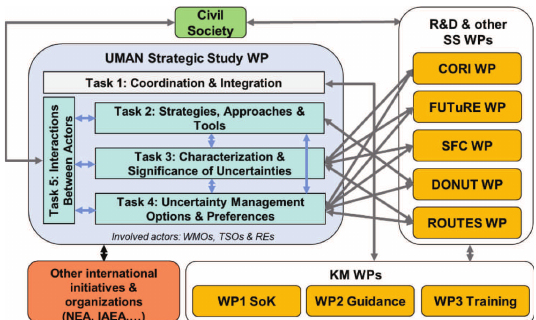
Fig. 1. UMAN structure, activities and interactions inside and outside